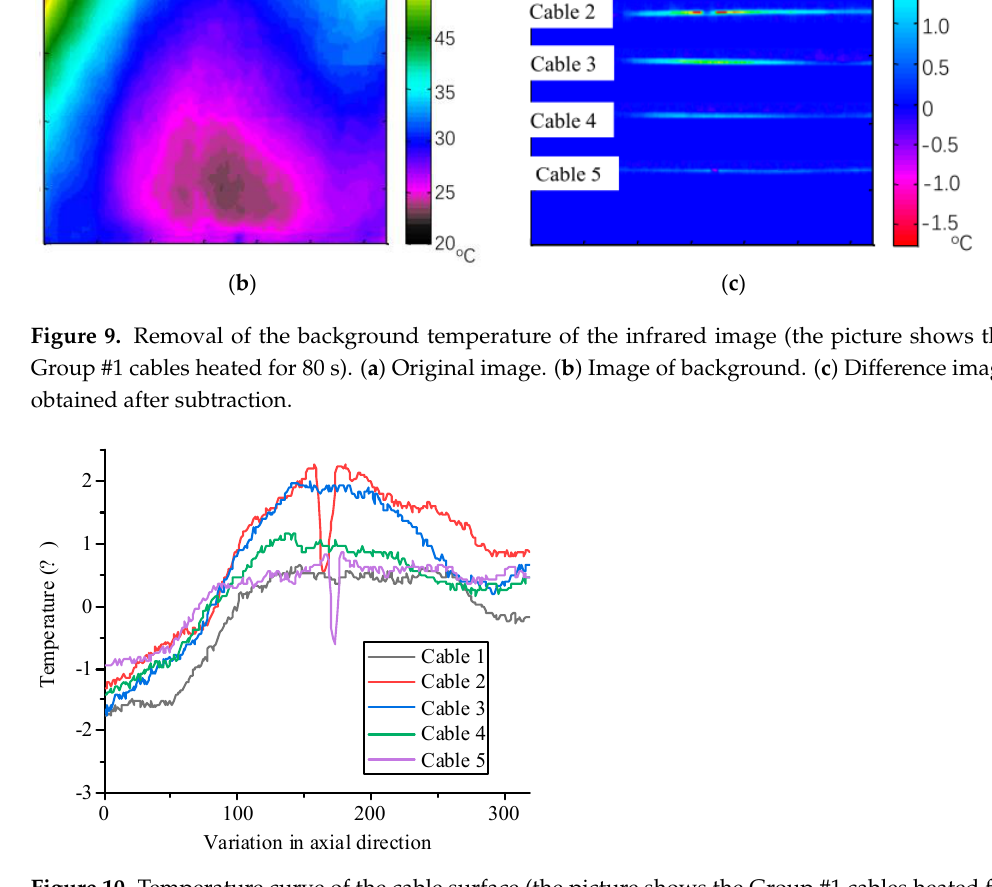
Figure 9. Removal of the background temperature of the infrared image (the picture shows the Group #1 cables heated for 80 s). ( a ) Original image. ( b ) Image of background. ( c ) Difference image obtained after subtraction.